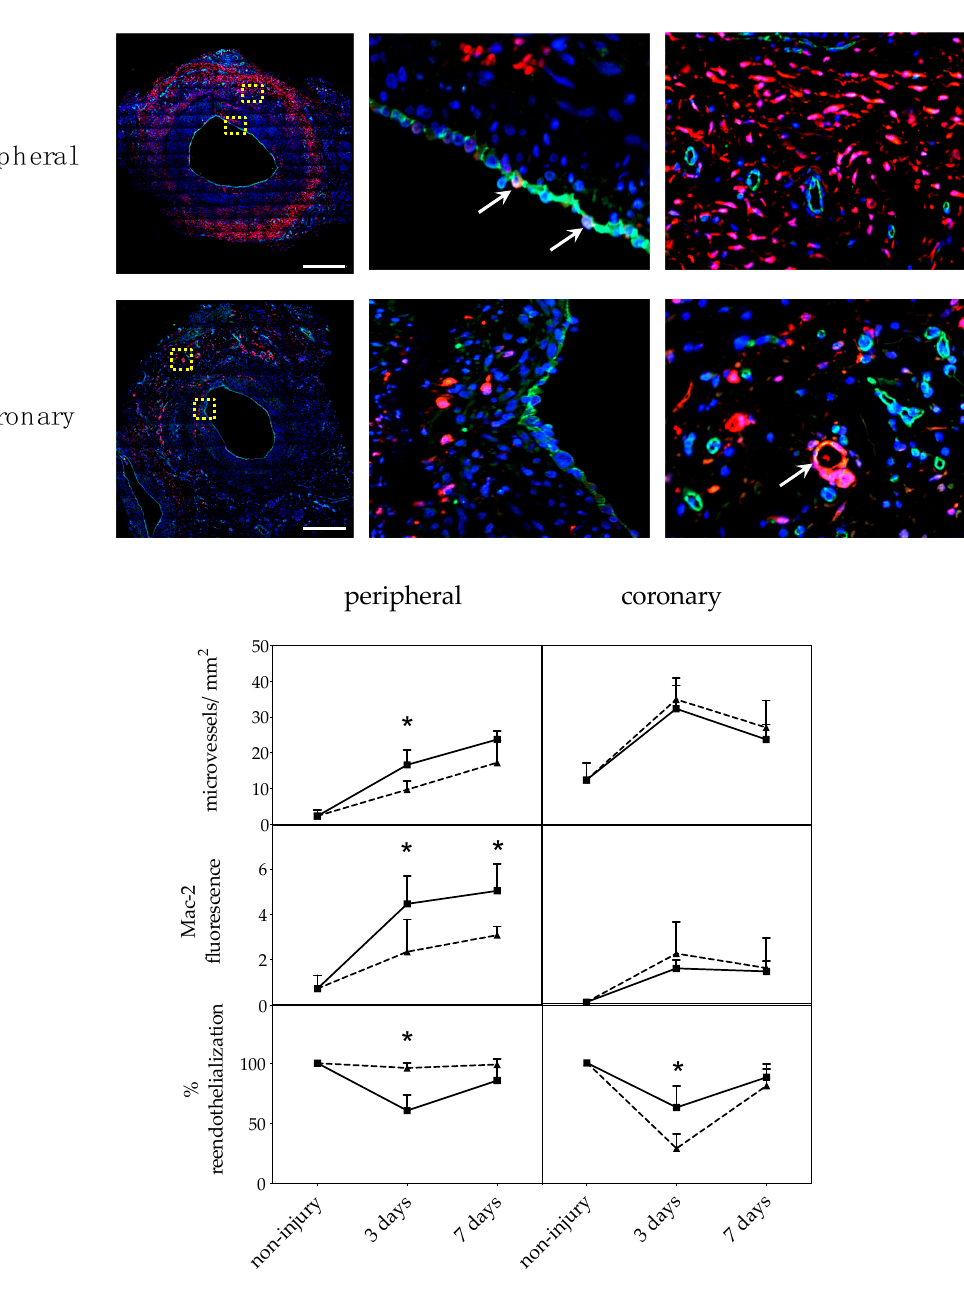
Figure 2. ( a ) Immunofluorescence. CD31 / Mac-2 double-stained cross sections of representative coronary and peripheral arteries 7 days post injury treated with uncoated balloon catheters. Red: Mac-2; green: CD31, blue: DAPI. Yellow boxes are shown enlarged next to the picture. Arrows indicate double positive cells. Bar = 0.5 mm. ( b ) Immunohistological analysis. CD31 / Mac-2 double staining. Two sections from at least two section levels per vessel were analyzed. n : Number of arteries; n = 4 peripheral; n ≥ 5 coronary; values are mean ± SD; p -value determined by Mann–Whitney test; * p ≤ 0.05. Table 1. Summary of results. n -value: Number of arteries included; I + M: Intima–media area; Macrophages: Relative fluorescence of immunofluorescent-stained Mac-2; values are mean ± SD; p -value determined by Mann–Whitney test; * p ≤ 0.05.